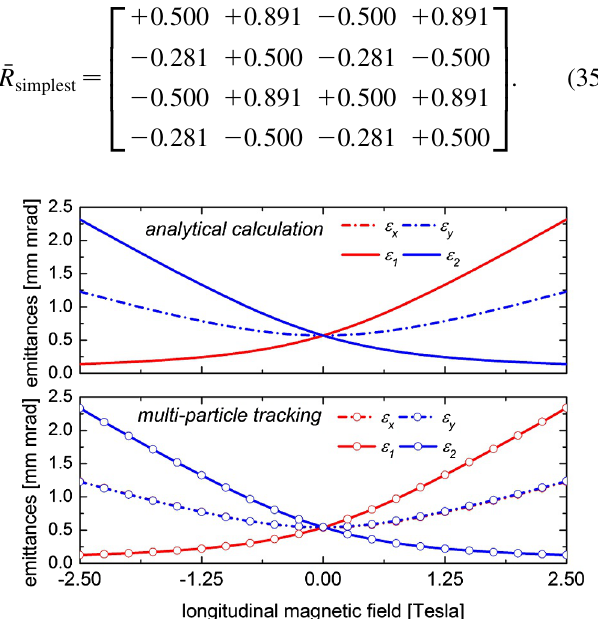
FIG. 3. Eigen-emittances and rms emittances calculated by the analytical method based on the short solenoid transfer matrix of Eq. (16) and by multiparticle tracking through three-dimensional field